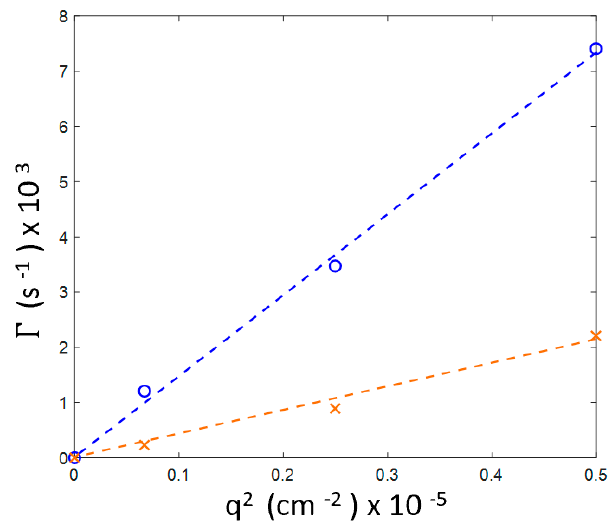
Figure 4. Wave number dependence for three scattering angles (30 ◦ , 60 ◦ and 90 ◦ , q ∝ sin ( θ /2 ) of the two decay rates in the 20 mg / mL sample after 90 h of holding at 60 ◦ C (see Figure 3b). Blue line: fast mode (smaller aggregates), orange line: slow mode (larger aggregates).